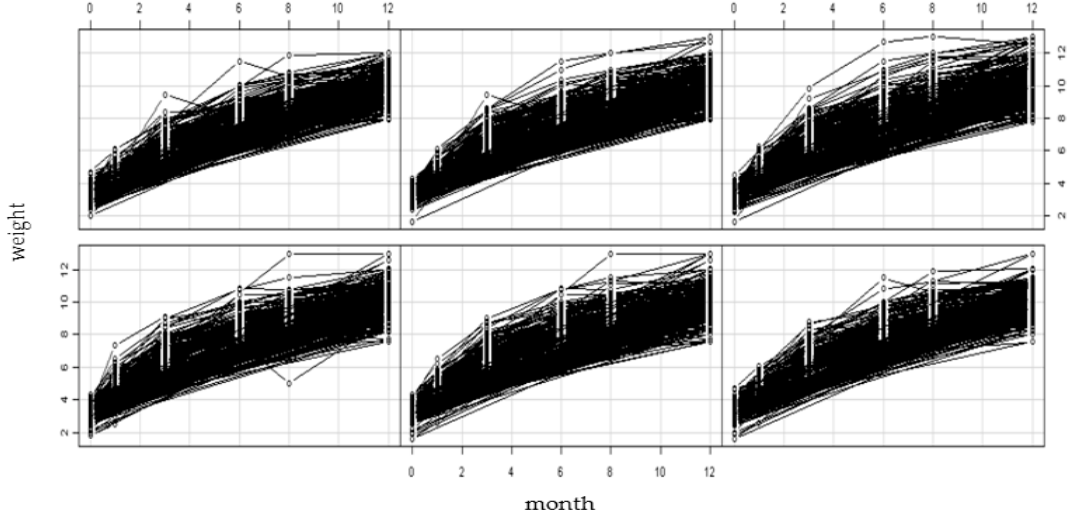
Figure 2. The weight growth tracks for 519 infants aged from 0 to 12 months old were represent based on panel data via R software. In order to look clearly, we divided the weight growth tracks into six equal parts in the picture according to their sequential panel ID. Each curve was corresponding to an infant, showing the tracks of infants’ weight growth. Table 5. Results of relationship between infant sleep and their weight based on the panel data models (According to a longitudinal community-based retrospective birth cohort study conducted in Changsha in 2013–2014).